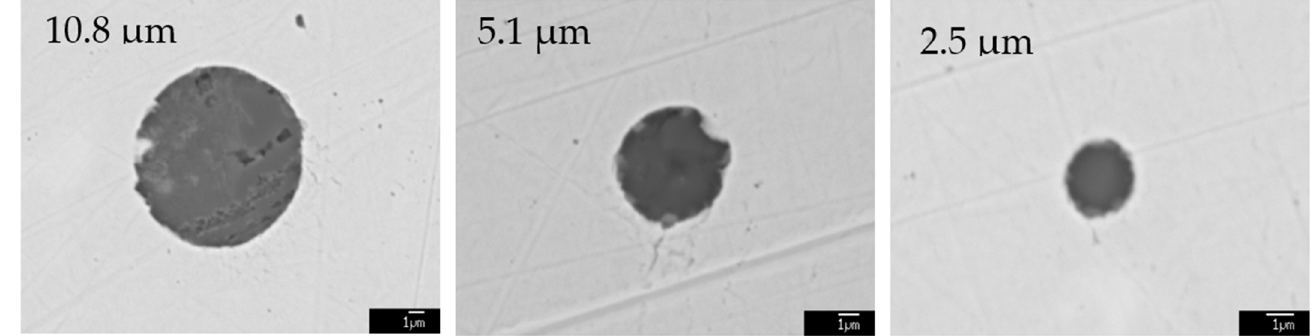
Figure 4. Morphologies of typical inclusions with different sizes after Ti